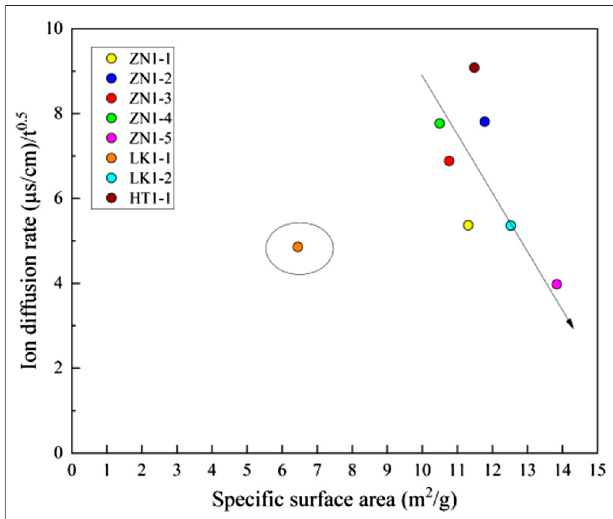
FIGURE 13 | The relationship between ions diffusion rate and speci fi c surface area.